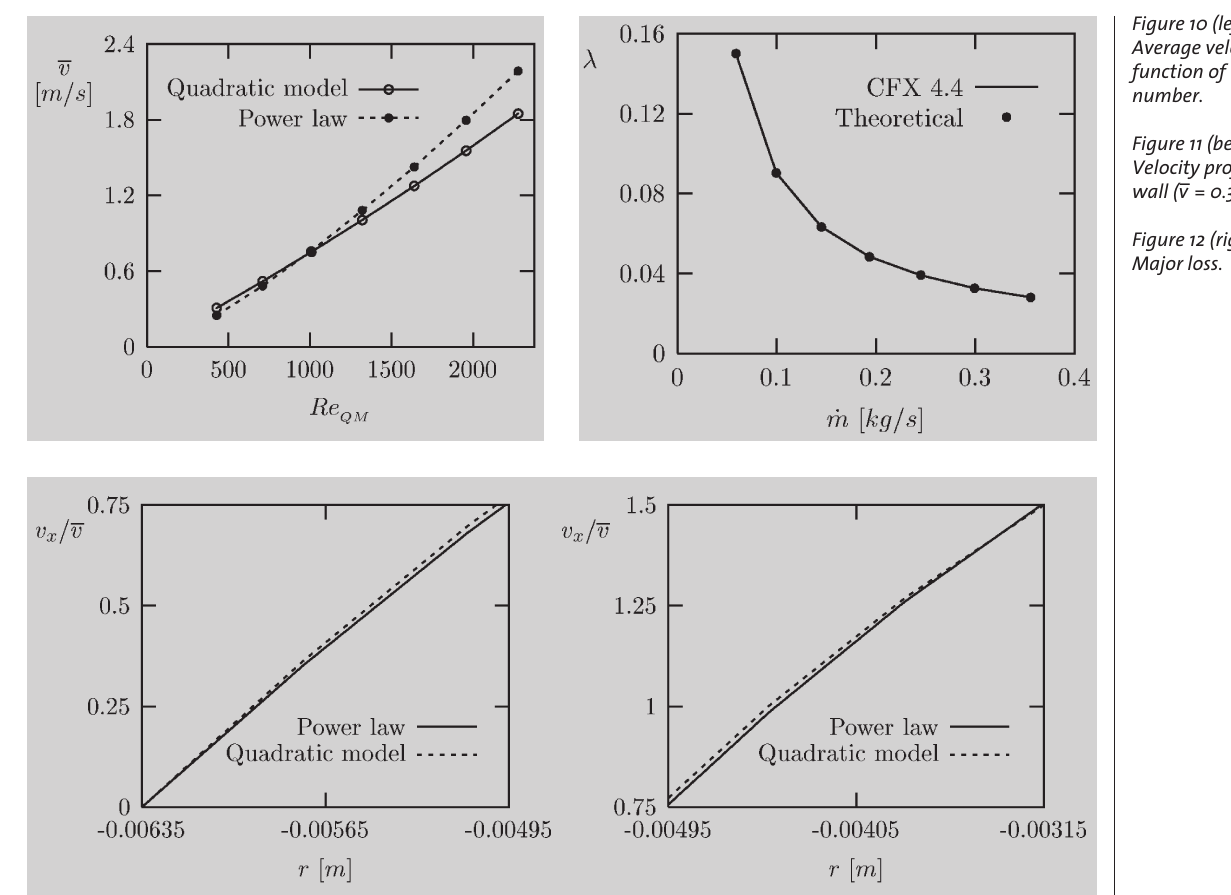
Figure 10 (left above): Average velocity as a function of the Reynolds number. Figure 11 (below): Velocity profile near pipe wall (v– = 0.307 m/s). Figure 12 (right above): Major